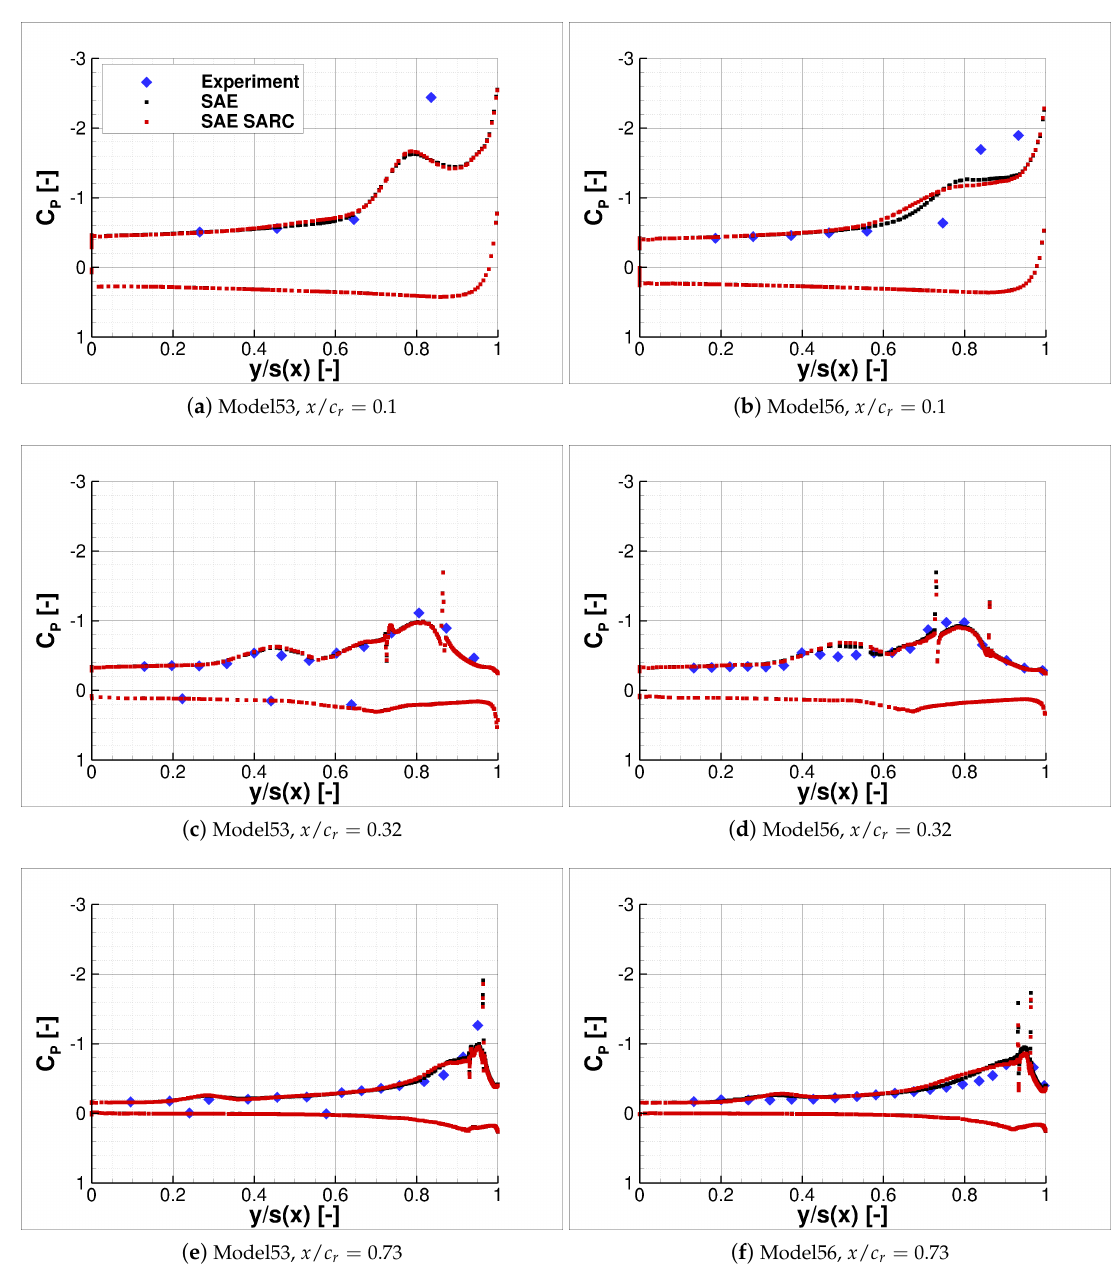
Figure 15. Surface pressure coefficient distribution C p against local semi-span y / s at α = 10 ◦ for Model53 and